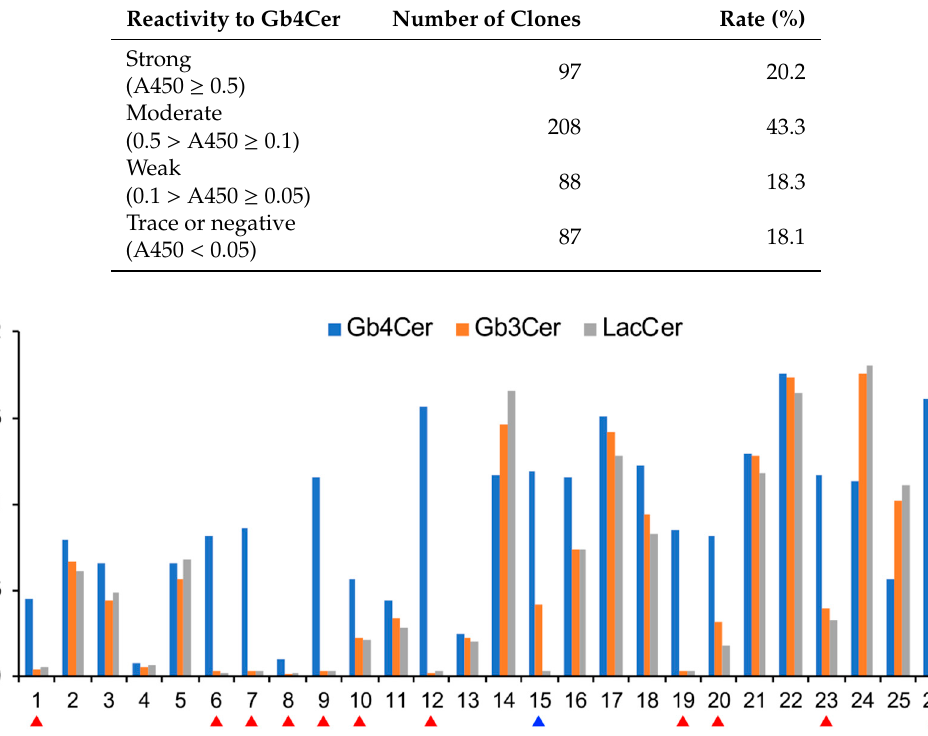
Table 2. Number of hybridoma clones producing antibodies with high reactivity to Gb4Cer and Gb3Cer.